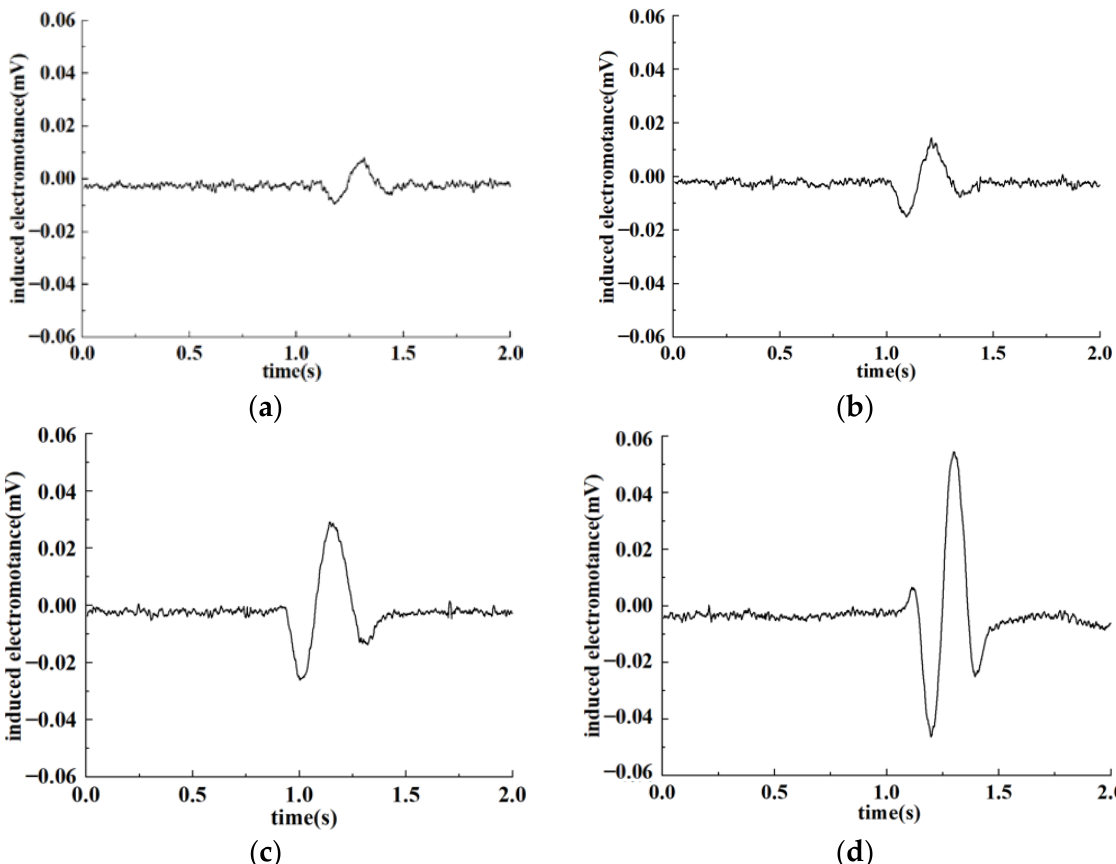
Figure 11. Detection results of ferromagnetic particles. ( a ) 103.33 μm; ( b ) 134.59 μm; ( c ) 167.1 μm; ( d ) 250.53 μm.